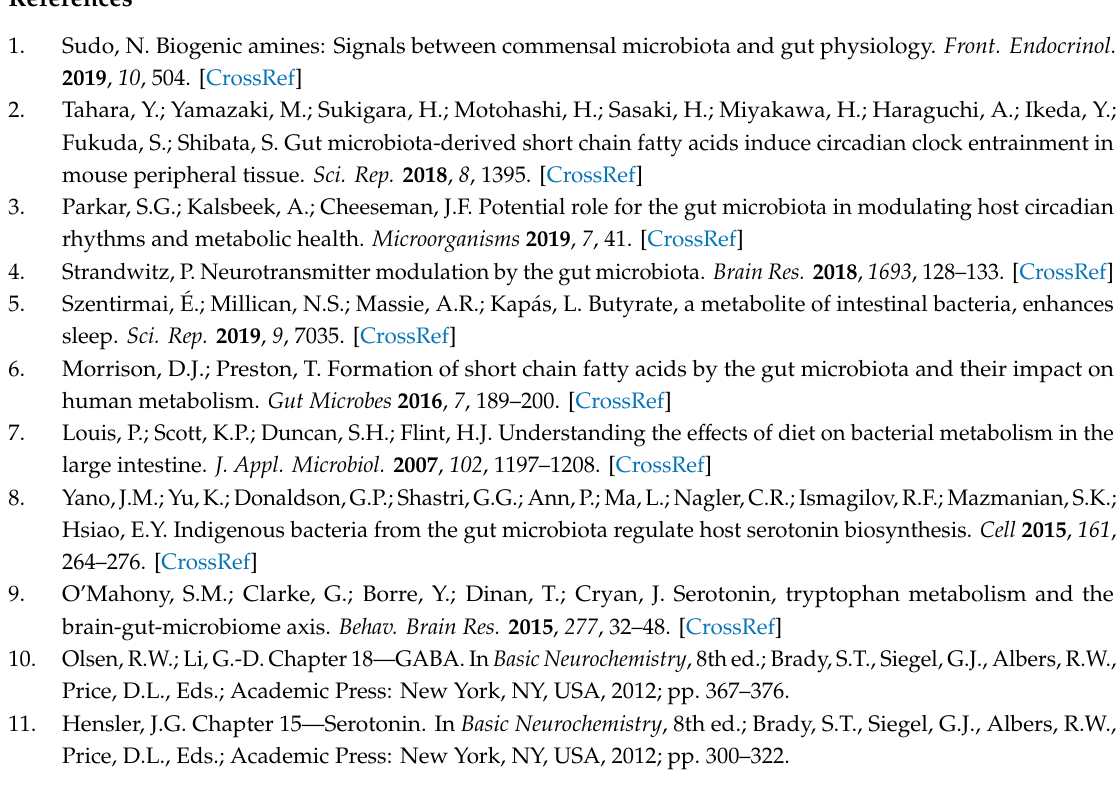
Figure S1: Schematic outlining the biogenic amines generated by the tryptophan, tyrosine and the glutamate metabolism pathways, Figure S2: The derivatization schematic for the LC-MS method to analyze biogenic amines, Figure S3: Workflow prior to LC-MS analysis of biogenic amines, Figure S4: Transitions monitored during LC-MS quantitation of biogenic amines, Figure S5: Concentrations of di ff erent bioamines after various stages of gastrointestinal digestion and fermentation of kiwifruit, Figure S6: A principal components analysis plot visualizing the influences of the substrates in generating organic acid metabolites over the duration of the fecal microbial fermentation (0, 2, 5 and 18 h), Figure S7: Mean relative frequency of microbiota of samples at phylum level, Figure S8: Mean relative frequency of microbiota of samples at order level, Figure S9: Mean relative frequency of microbiota of samples at family level, Figure S10: Diversity analysis examining changes in microbial community within samples, Figure S11: Principal co-ordinate analysis plot demonstrating β -diversity di ff erences between samples, based on the Bray-Curtis index, Table S1: Multiple Reaction Monitoring (MRM) transitions used for biogenic amine analysis, Table S2: Multiple Reaction Monitoring transitions used for organic acid analysis, Table S3: Intestinal gene targets analyzed, Table S4: Relative changes in microbiome abundance in fermenta after 18 h of fermenta, Table S5: Mean counts of Caco-2 cell